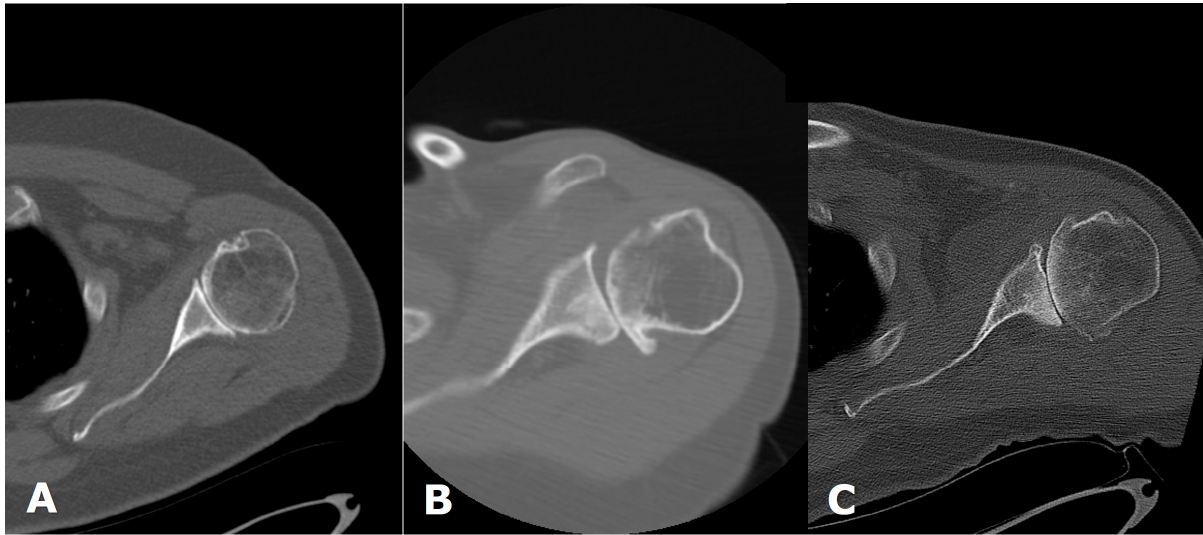
Figure 6. Axial computed tomography (CT) images of the shoulder in three different patients, showing different glenoid morphologies. ( A ). Walch A. ( B ). Walch B1. ( C ). Walch B2.